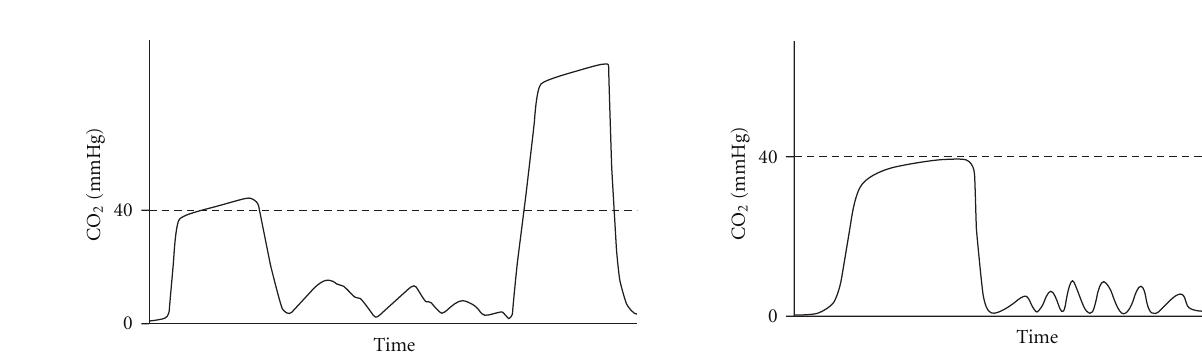
Figure 3: Hypoventilation with a shallow breath followed by a deep breath.